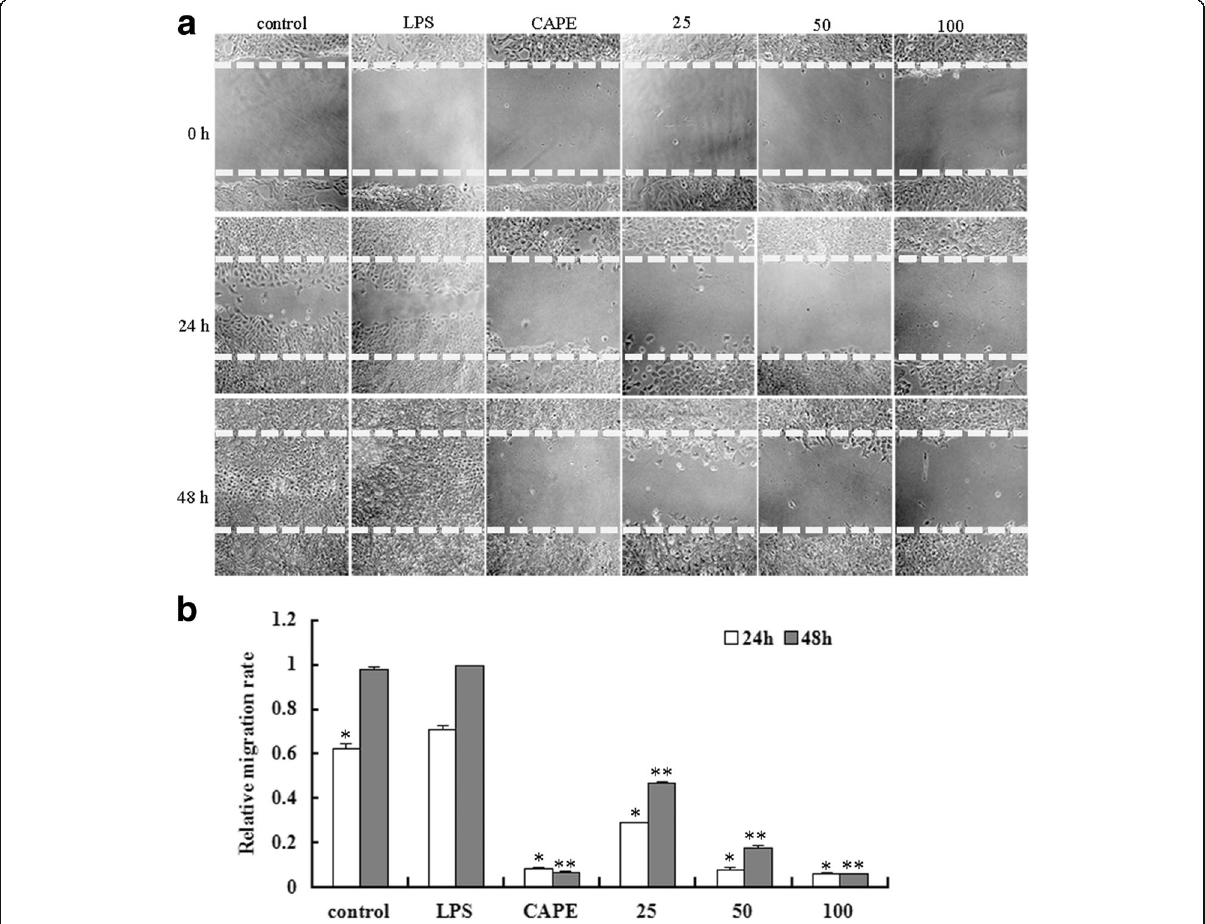
Fig. 3 EECP and CAPE inhibited LPS-stimulated MDA-MB-231 cells migration. a Cell migration micrographs obtained under a phase contrast